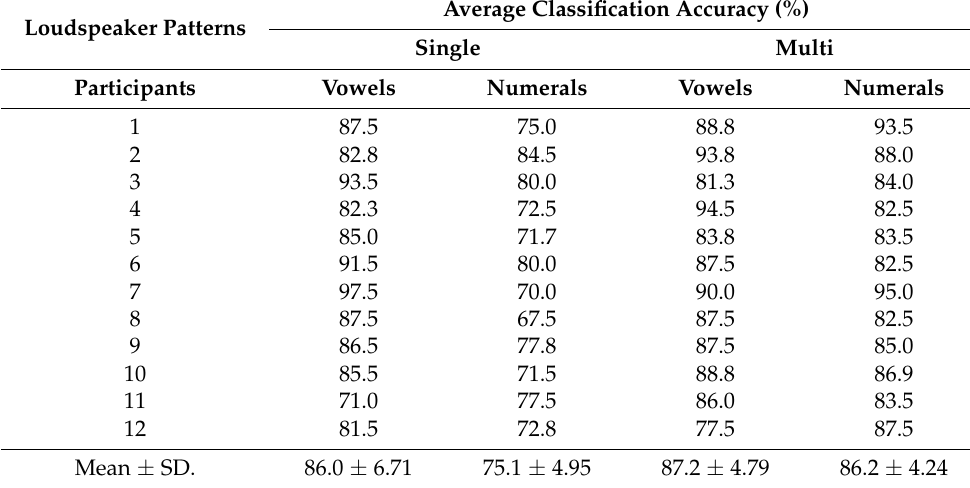
Table 6. Results of the average classification accuracy under different loudspeaker patterns of vowel and numeral stimuli for each